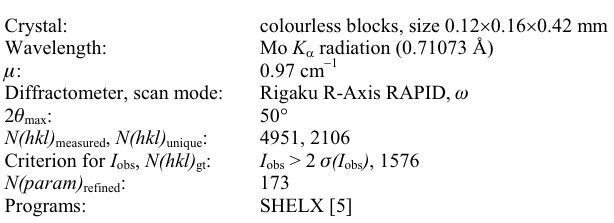
Table 1. Data collection and handling.